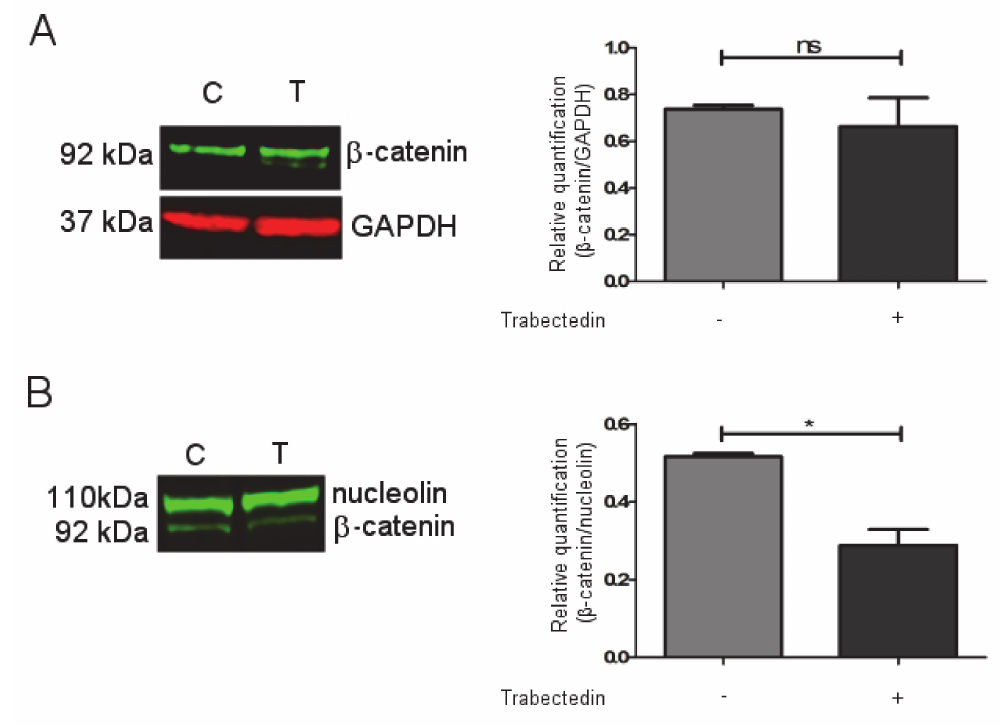
Figure 4. E ff ect of trabectedin on the β -catenin expression by Western blot (WB) technique. NCI-H295R cells were exposed to 0.15 nM of trabectedin for 3 days. ( A ) A representative WB on total lysate is shown. ( B ) A representative WB on nuclear protein fraction is shown. * p < 0.01. ns: not significant.